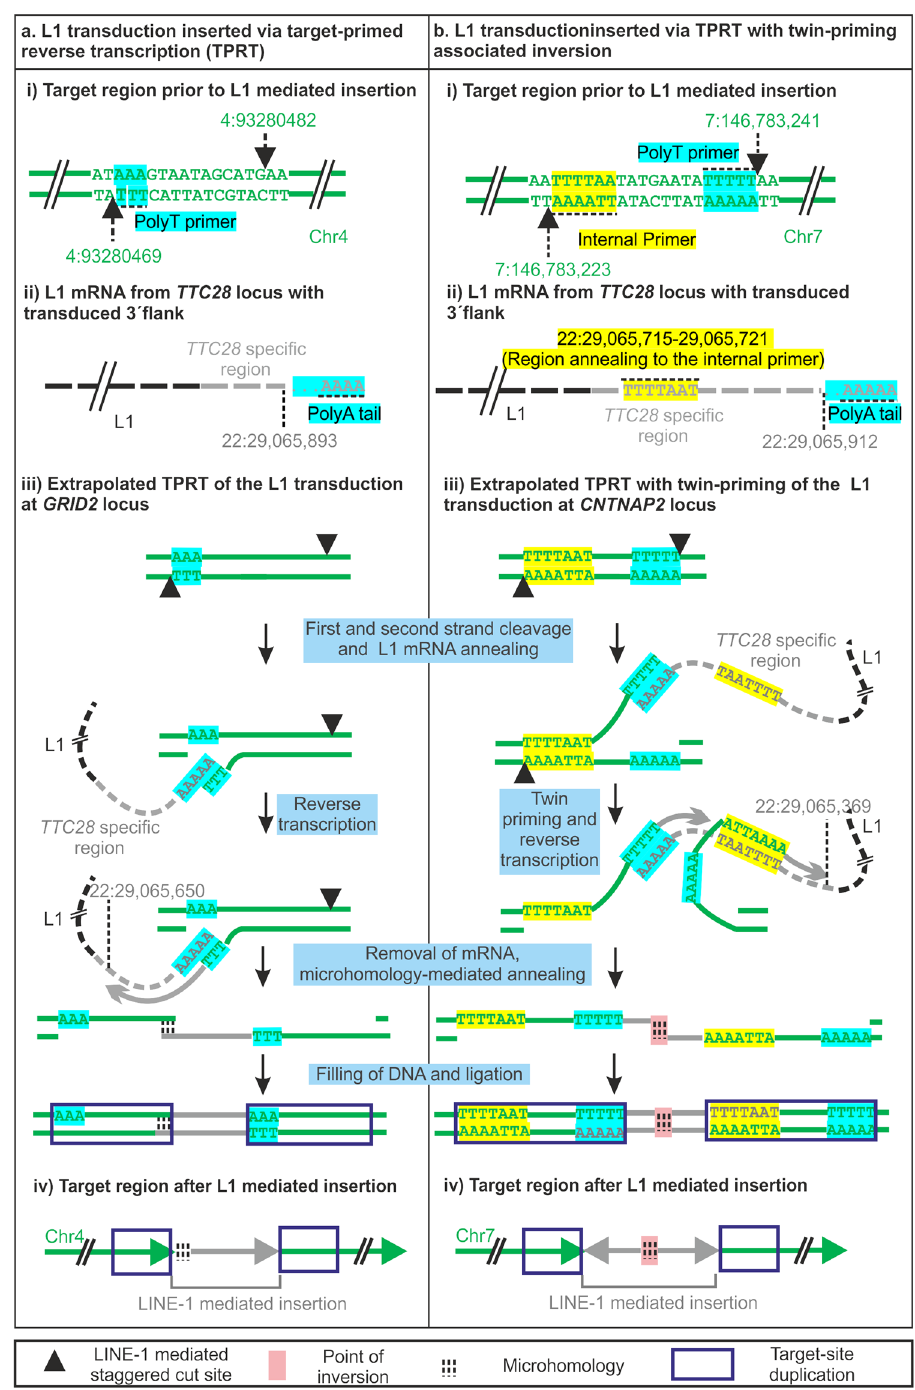
Figure 5. Extrapolated mechanism of L1 insertion at ( a ) GRID2 locus and ( b ) CNTNAP2 locus In both ( a ) and ( b ) (i) shows locations of staggered double-stranded cleavage in the target region with PolyT primer in the 3 ′ overhang and an internal primer (when used) in the 5 ′ overhang ( b ). (ii) Extrapolated L1 mRNA with the TTC28 3 ′ unique tag. Regions complementary to the polyT primer and internal primer at target site is highlighted by the same colour scheme. (iii) Schematic representation of the TPRT ( a ) and twin-priming ( b ) mechanism of TTC28 specific 3 ′ transduction in the GRID2 ( a ) and CNTNAP2 ( b ) locus. Figures are not drawn to